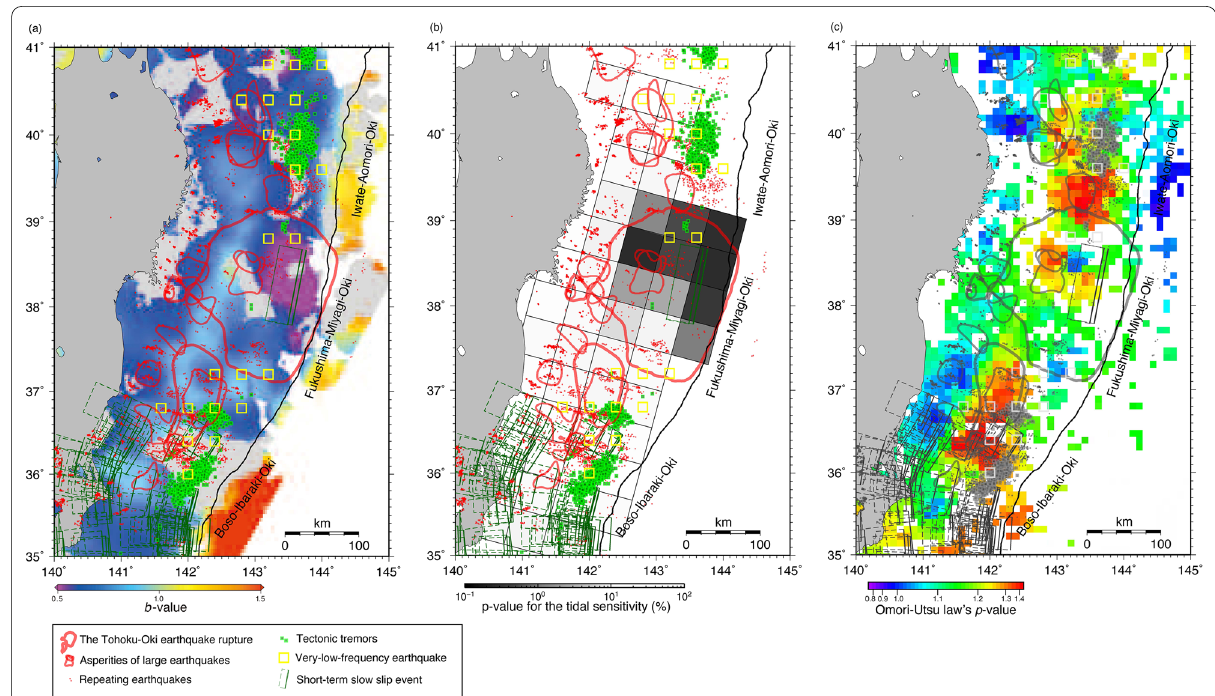
Fig. 10 Comparison between spatial distributions of seismicity parameters and the slow earthquake distribution in the Japan Trench. a Gutenberg–Richter relationship’s b value (Tormann et al. 2015). The b values were estimated from January 1, 2004, to March 11, 2011. In gray areas, Tormann et al. (2015) did not estimate b values because the magnitude–frequency distributions of the areas were not well described by the Gutenberg–Richter relationship. b Tidal response of seismicity (Tanaka 2012). p values of Schuster’s test during the 3000 days prior to the Tohoku-Oki earthquake are shown. A low p value indicates a high tidal response. The p values were calculated for seismicity in spatial windows of 200 km 200 km, whose centers correspond with the centers of the squares of 50 km 50 km in the figure (the black squares). c p value of the × × Omori–Utsu’s aftershock law (Ogata 2011). The p values were estimated using M j 5 or greater earthquakes from 1926 to 2008. Note that the slow and fast earthquakes are colored gray in ( c ). For an explanation of the symbols, refer to the legend in the figure. The slow earthquakes, megathrust earthquakes, and small repeating earthquakes are from Fig.